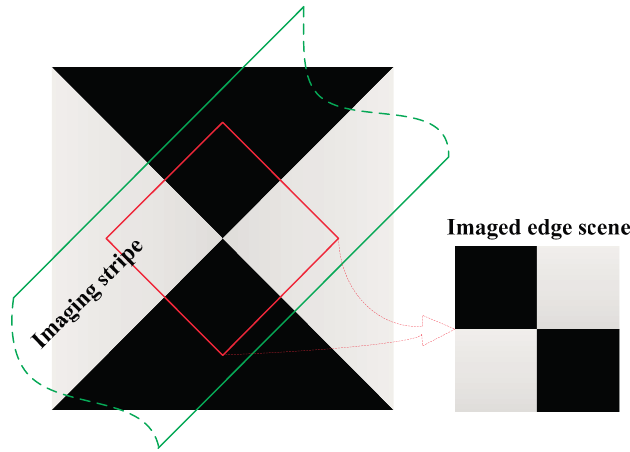
Figure 6. The synthetic edge scene. The left is the synthetic edge scene, the region enclosed by green line is the imaging stripe, and the right is the imaged edge